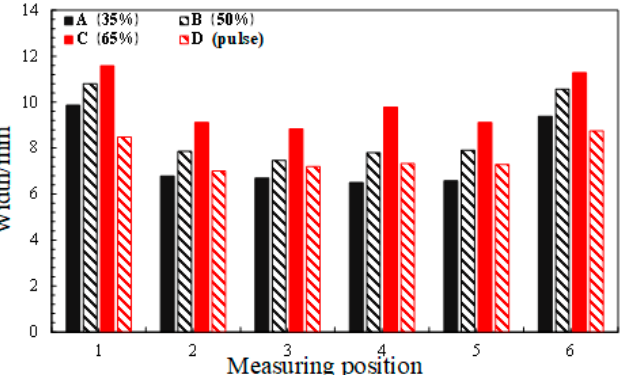
Figure 7. Six-point widths of four parts.